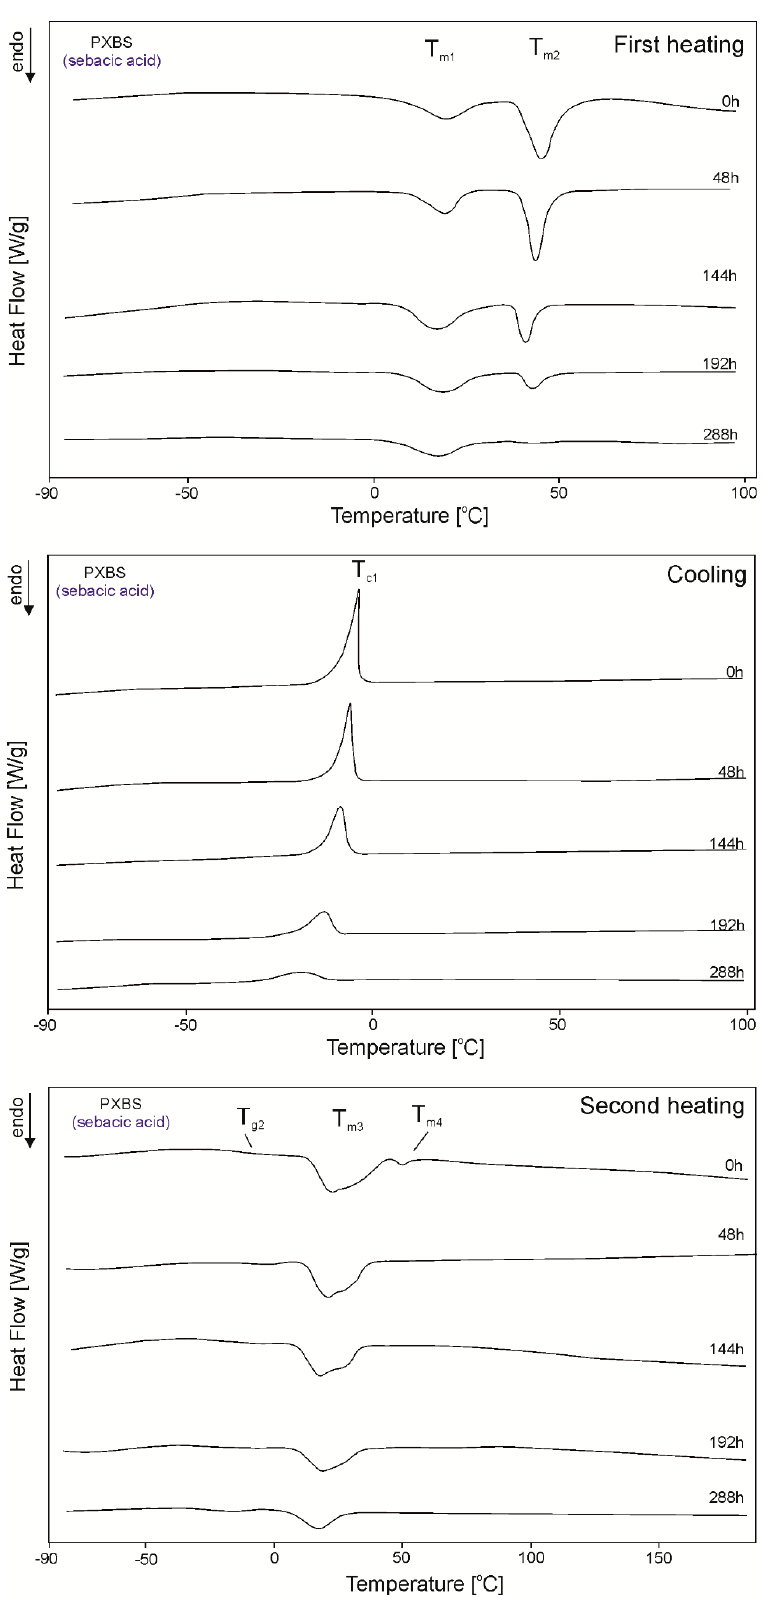
Figure 7. DSC thermograms of PXBSb at the crosslinking stages subjected to first heating, second heating and cooling.